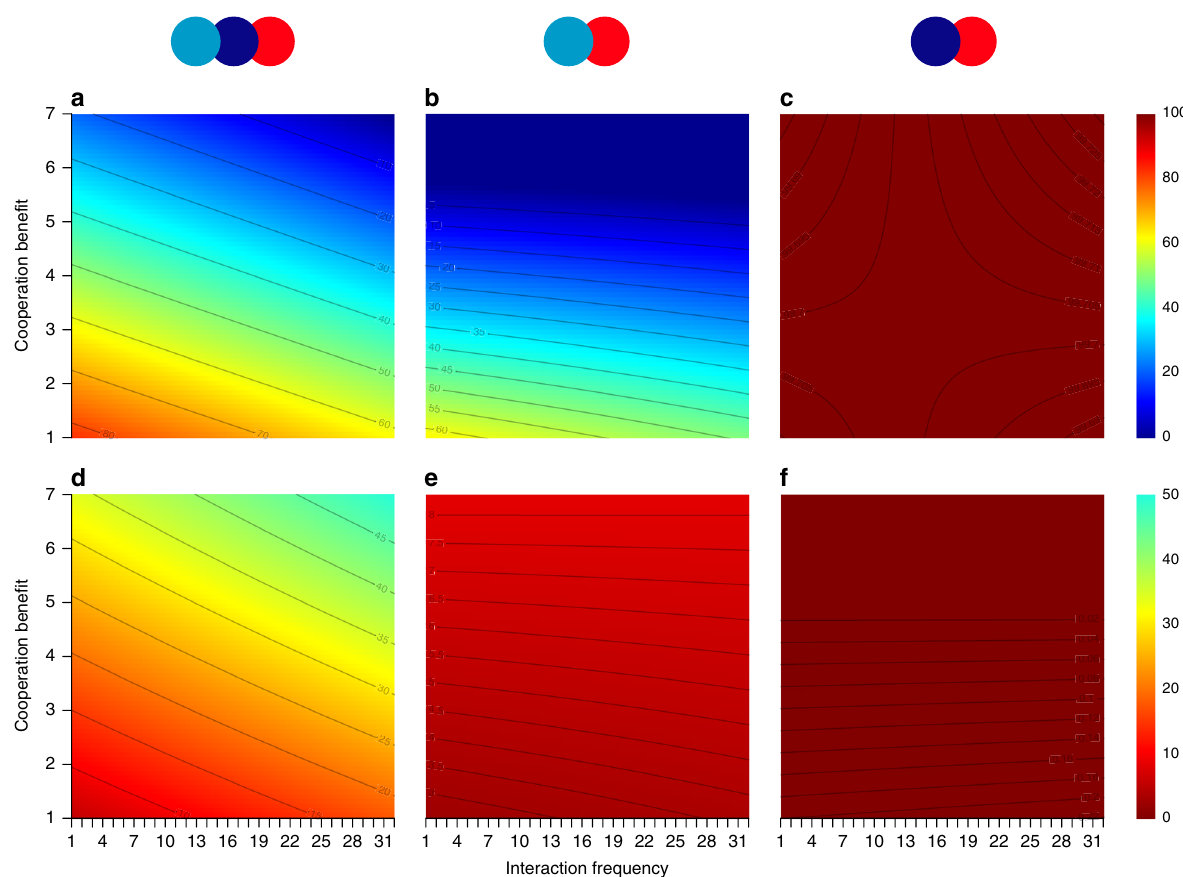
Fig. 4 Cooperation and free-riding across the parameters space. The proportion of free-riders (upper row) decreases with higher interaction frequency i and return on cooperation b with all three-strategies ( a ) and friend-focused vs. free-rider strategies ( b ), but free-riding dominates when Heider agents compete against free-riders ( c ). Cooperation (in percentage of interactions — lower row) only reaches signi fi cant levels with all three strategies present ( d ) and remains low in friend-focused vs. free-rider ( e ) and Heider vs. free-rider populations ( f